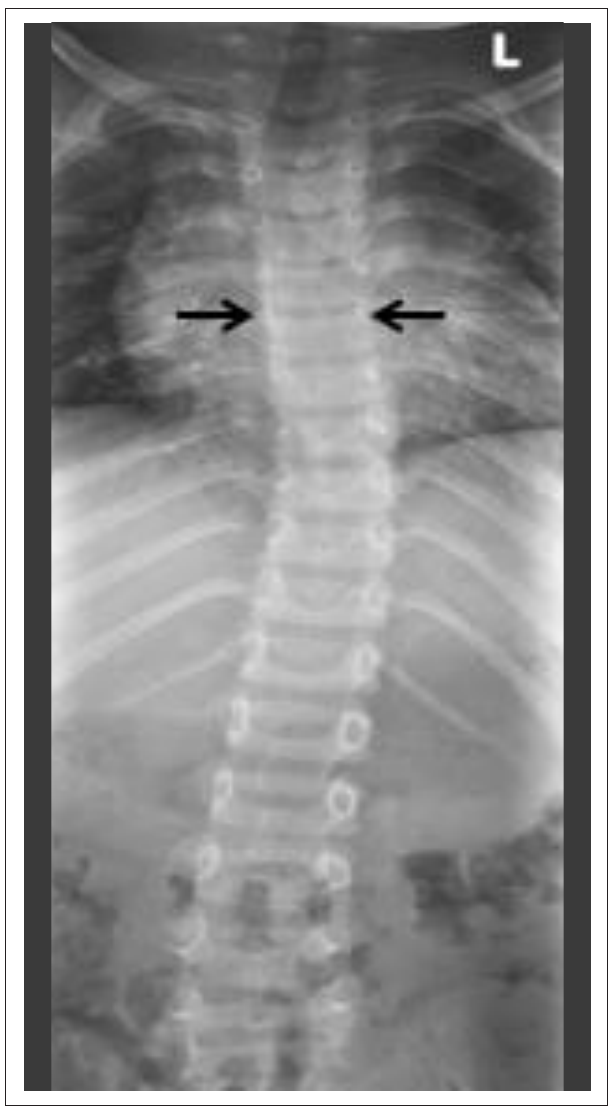
FIGURE 1: Anterior posterior view of the thoracolumbar spine shows levoscoliosis with apex at T7 and flattened pedicles from T5 to T7 in keeping with an intraspinal mass.